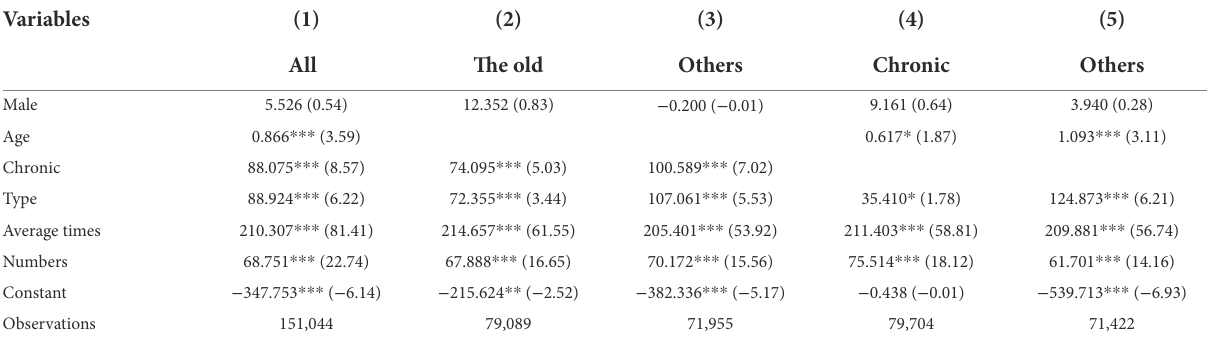
TABLE 7 Grouping regression results after substituting